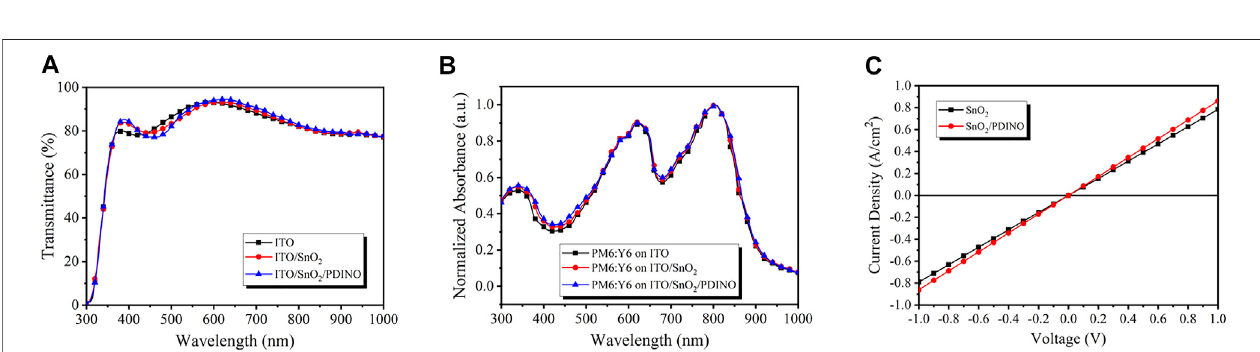
FIGURE2|(A) TransmittancespectraofITO,ITO/SnO 2 ,andITO/SnO 2 /PDINO. (B) NormalizedUV – visabsorptionspectraofPM6:Y6onITO,ITO/SnO 2 ,andITO/ SnO 2 /PDINO. (C) J – V curves of ETLs with and without PDINO modi fi